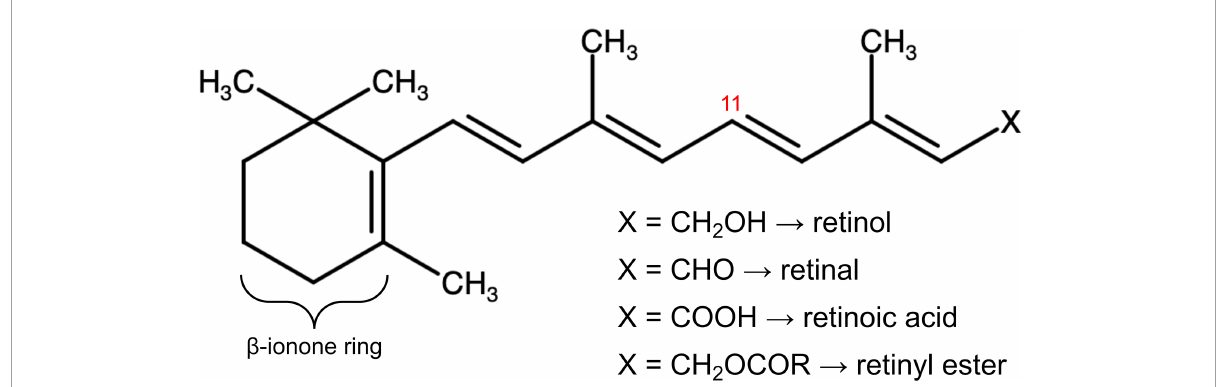
FIGURE1 The molecular structure of vitamin A in its multiple forms. The chemical group denoted X defines retinol, retinal, retinoic acid, and retinyl esters depending on its composition. Stereoisomeric 11-cis and 11-trans retinoids depend on the three-dimensional arrangement of the vitamin A molecule around the double bond at the eleventh carbon residue, labelled in red. The ß-ionone ring, modified in synthetic forms of vitamin A, is also labelled.